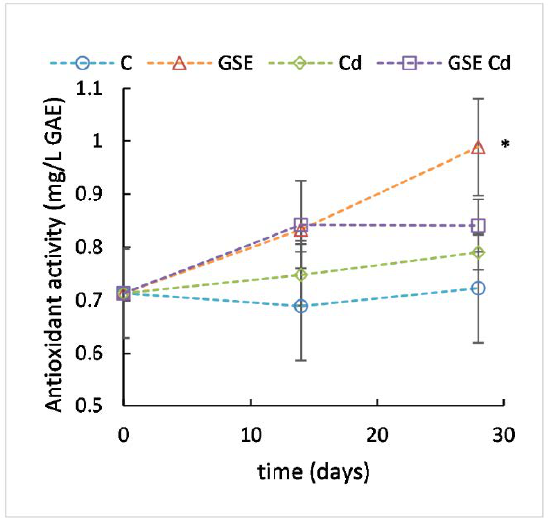
Figure 3. Plasma antioxidant activity for the control variant (blue line with circles), the variant with GSE addition (orange line with triangles), the variant with Cd addition (green line with diamonds), and the variant with both GSE and Cd addition (violet line with squares) on days 0, 14, and 28 of monitoring. Data are presented as means ± sd from three replicates. Data were analyzed by one-way ANOVA (each time point separately) and differences from control are marked: * indicates p ≤